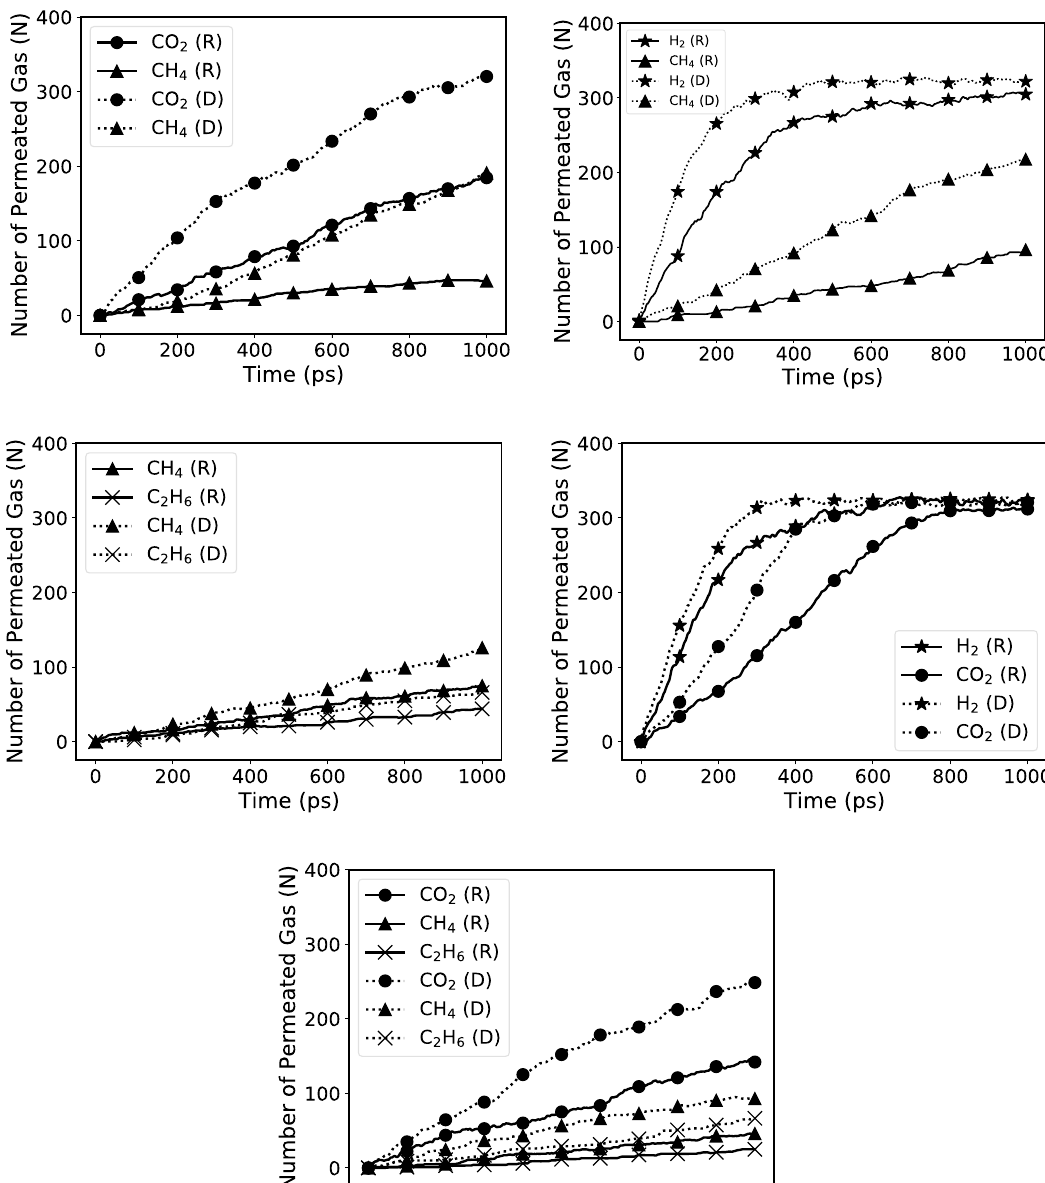
Figure 3. N, Number of gas molecules (H 2 : star, CO 2 : circle, CH 4 : triangle, C 2 H 6 : cross) permeated through graphyne-3 membrane in various mixtures versus time at 300 K and a pressure difference of about 30 bars. Each mixture was simulated under the assumption that the membrane is rigid (R, solid curves) or deformable (D, dotted